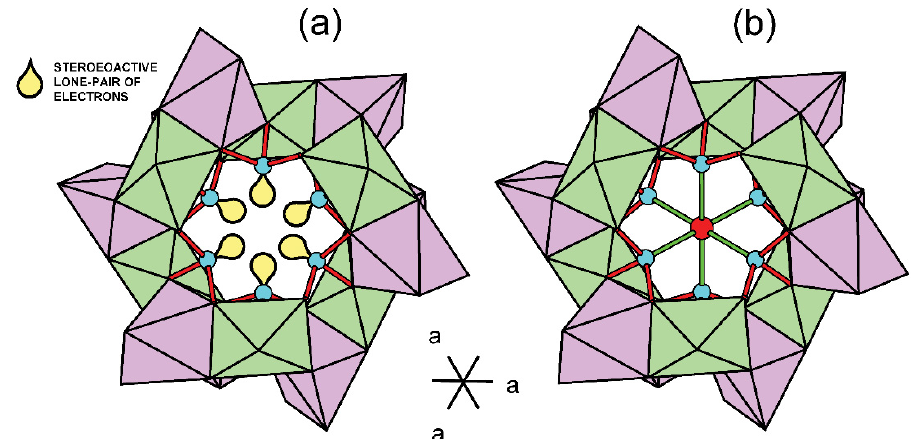
Figure 7. Local arrangement around ( a ) unoccupied MX site, and ( b ) occupied MX site in magnus- sonite channels.